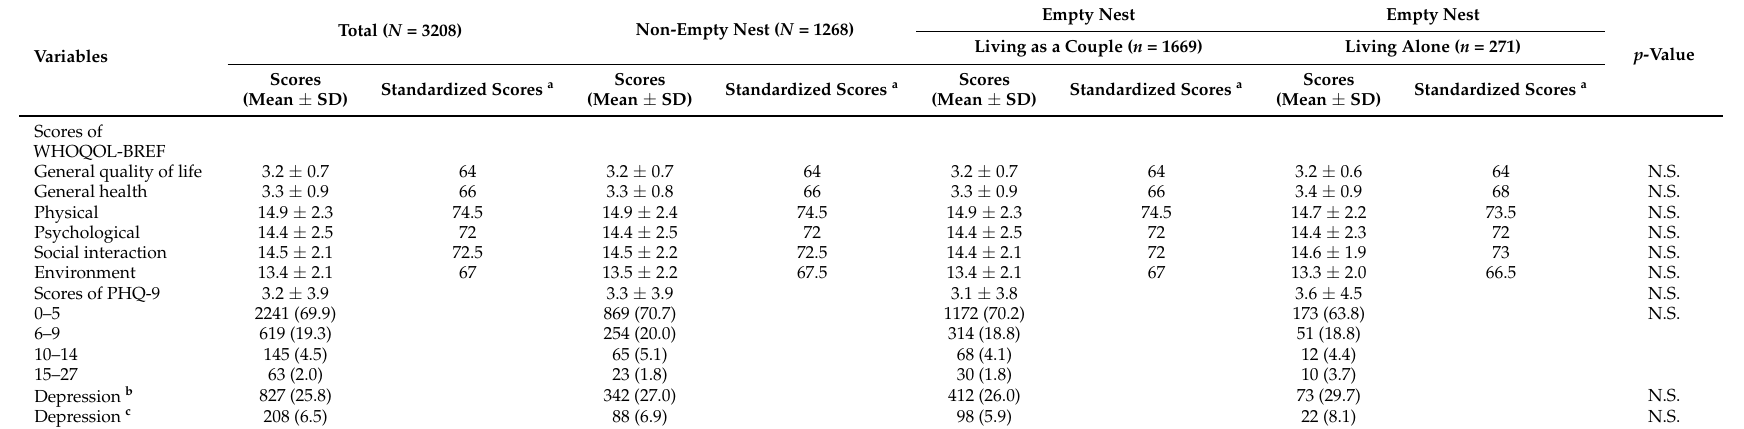
Table 3. Patient Health Questionnaire-9 scale and the World Health Organization Quality of Life questionnaire scores stratified by empty nest group and non-empty nest